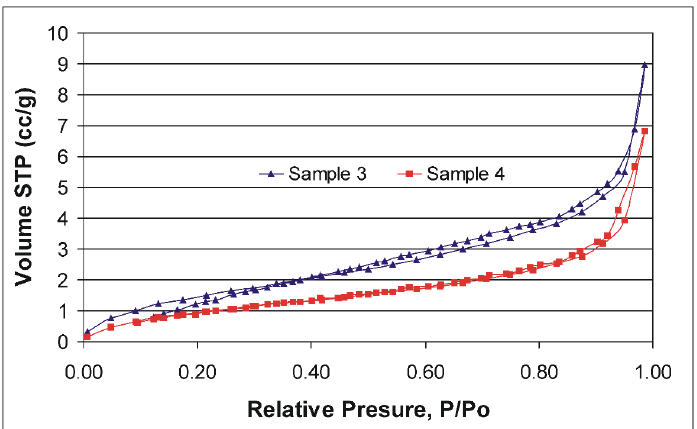
Figure 8. Nitrogen adsorption ‐ desorption isotherms for two selectedaminopropyl supports. 2.10. The Humic Acid (HA) Immobilization Tests of the Novel Aminosilica Supports